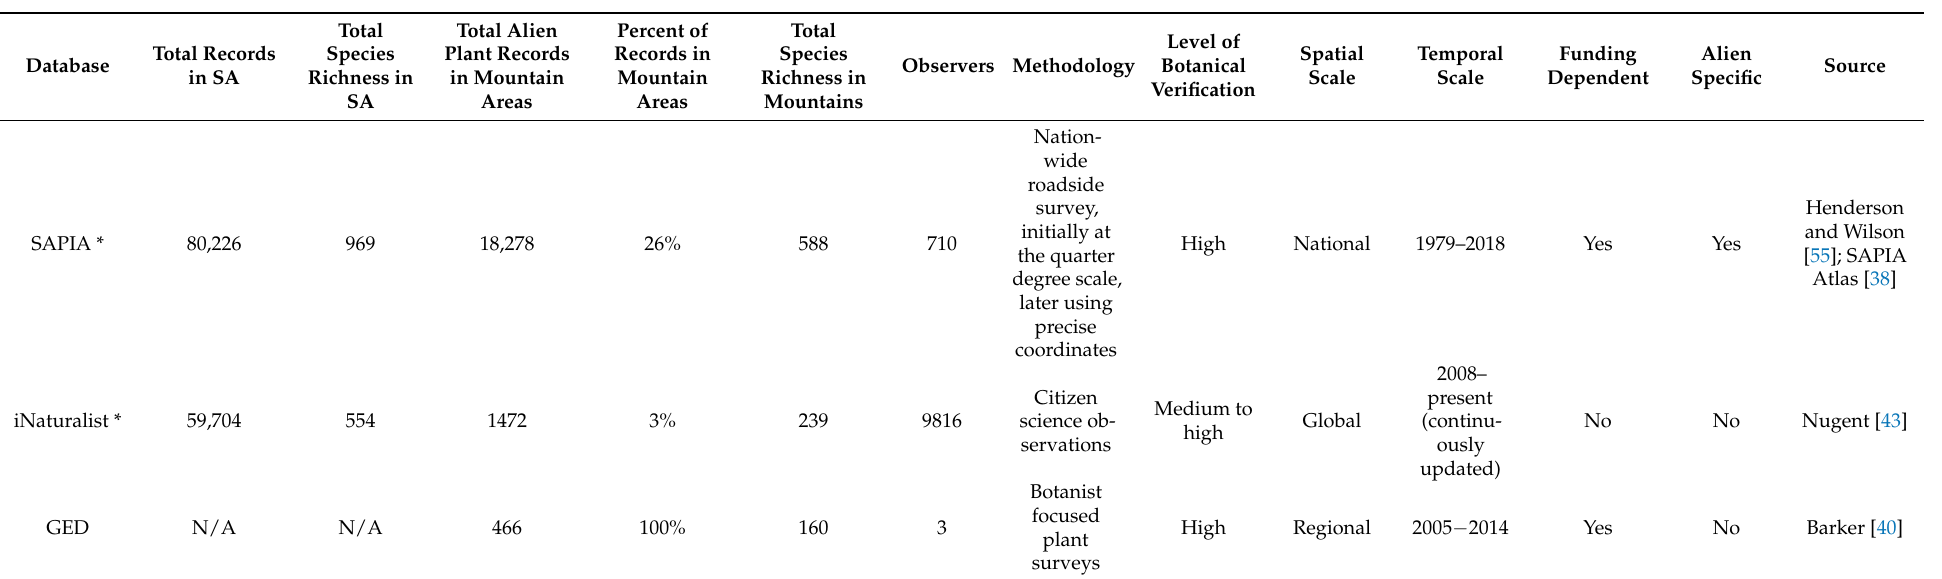
Table 1. The three databases used to determine alien plant species occurrences in montane areas of South